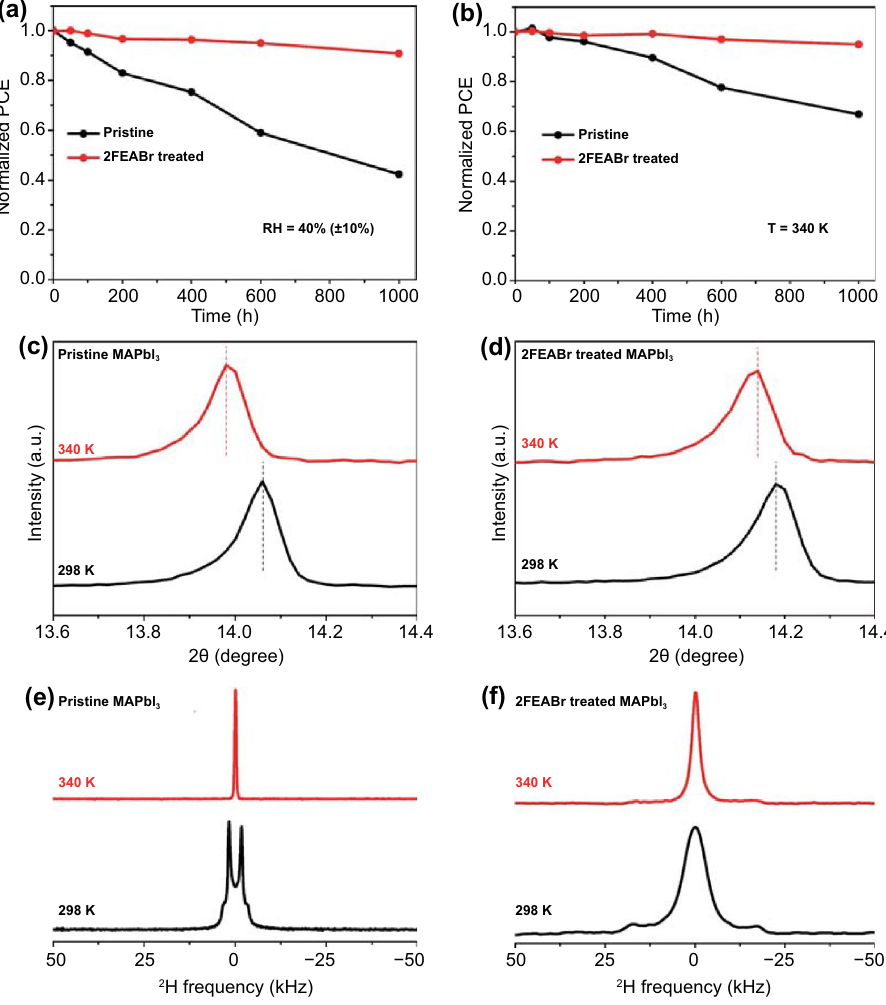
Fig. 4 a‑b Comparison of efficiency decay of unencapsulated PSCs as stored under 40% (± 10%) RH and 340 K, respectively. c–d Magnified XRD (100) peaks for pristine MAPbI 3 and 2FEABr treated MAPbI 3 at 298 K and 340 K, respectively. e–f 2 H NMR spectra of pristine MAPbI 3 and 2FEABr treated